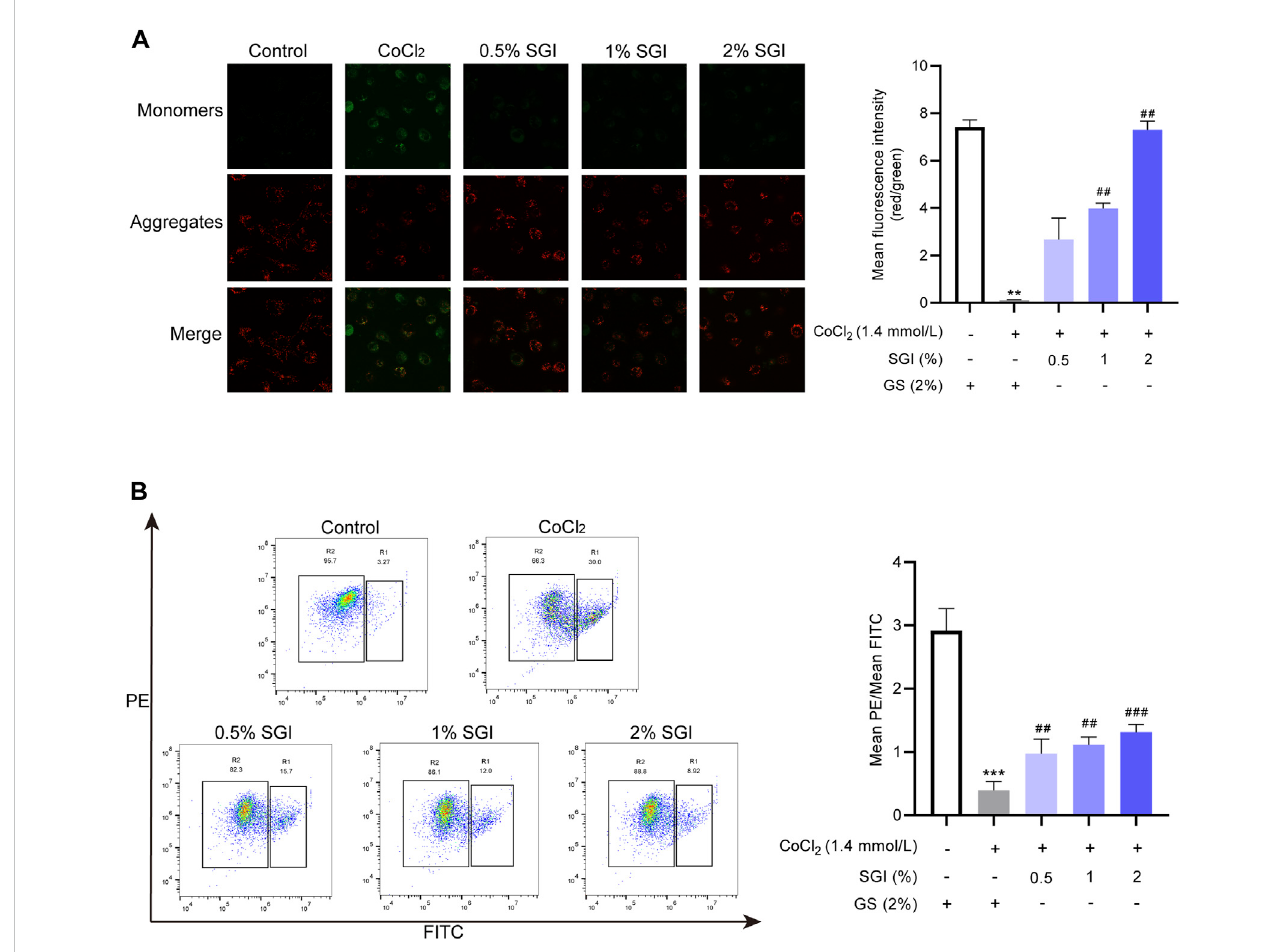
FIGURE 6 SGI attenuates CoCl 2 -induced MMP disruption in HUVECs. (A) Representative CLSM images showing the in fl uence of SGI (.5%, 1%, and 2%) on the MMP andhistogramsillustratingthatratioofredtogreen fl uorescence. (B) HUVECswereanalyzedby fl owcytometrytoquantifytheMMP.HighMMPisindicatedby red fl uorescence and low MMP is indicated by green fl uorescence. ** p < .001, *** p < .001 vs. the control group; ## p < .01, ### p < .001 vs. the CoCl 2